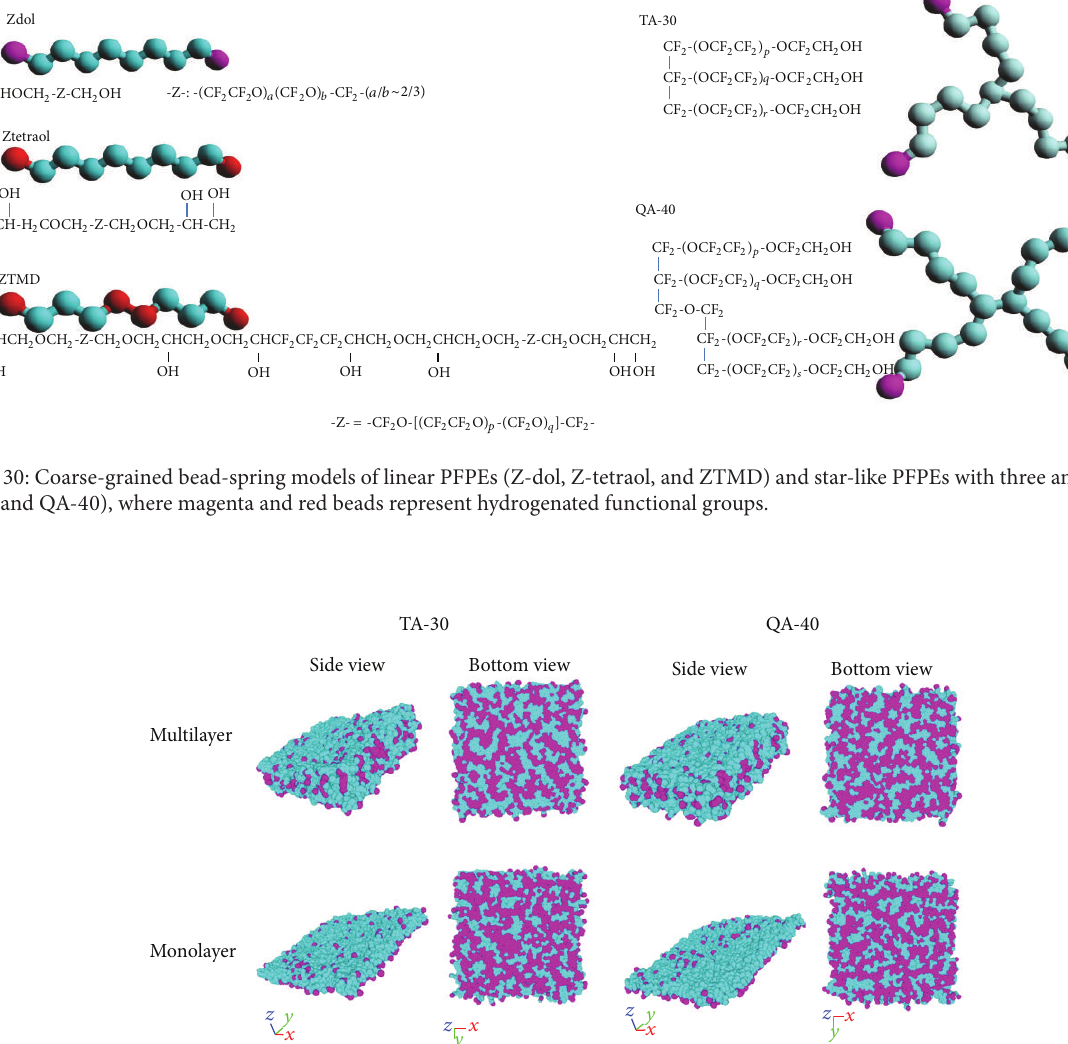
Figure 31: Snapshots of multilayer and monolayer TA-30 and QA-30: side and bottom views.